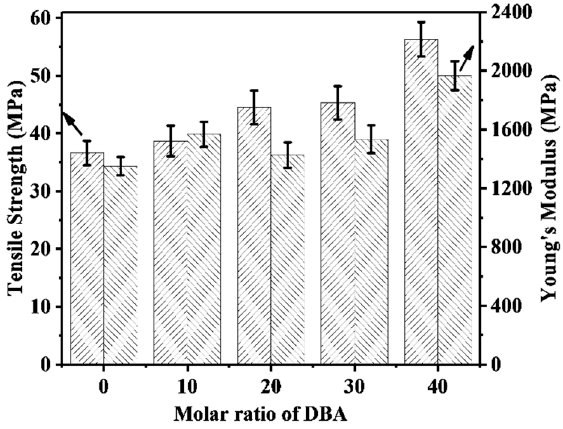
Figure 5. The mechanical properties of CSPEN-60-DBA-x.